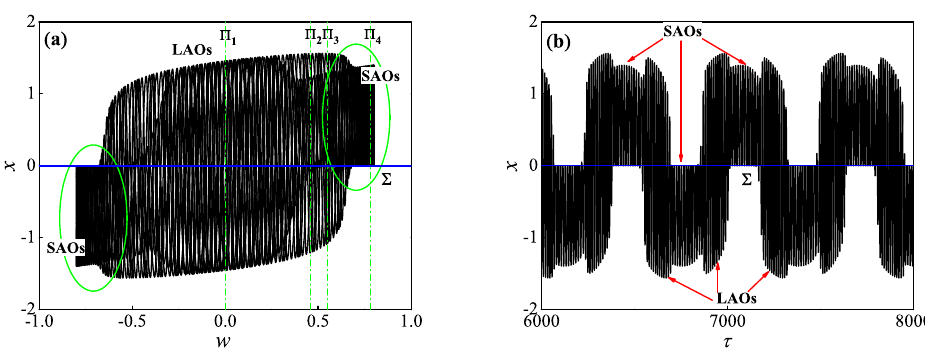
Figure 3. The MTSOs when Ω = 0.01, which is redrawn with considering nonsmooth structures. ( a ) Phase portrait in ( w , x ) plane; ( b ) time history of fast variable x .